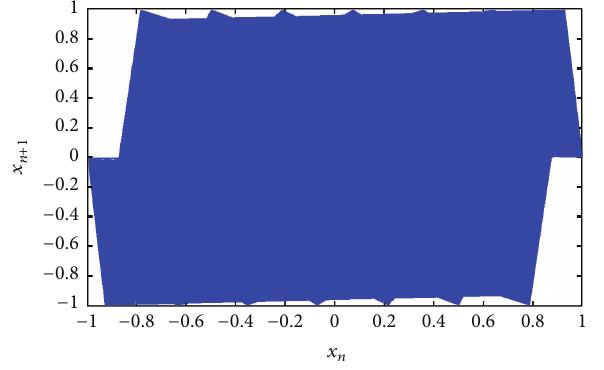
Table 1: The results of ergodicity property testing for 𝑓 𝑟